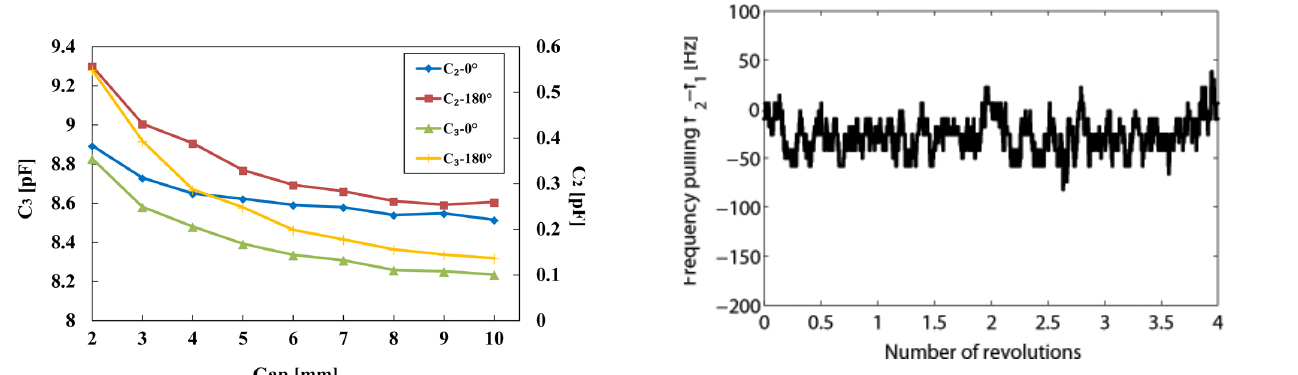
Figure 15. Calculated coupler capacitors C 2 (transmission) and C 3 (receiver element) variations at di ff erent gaps.